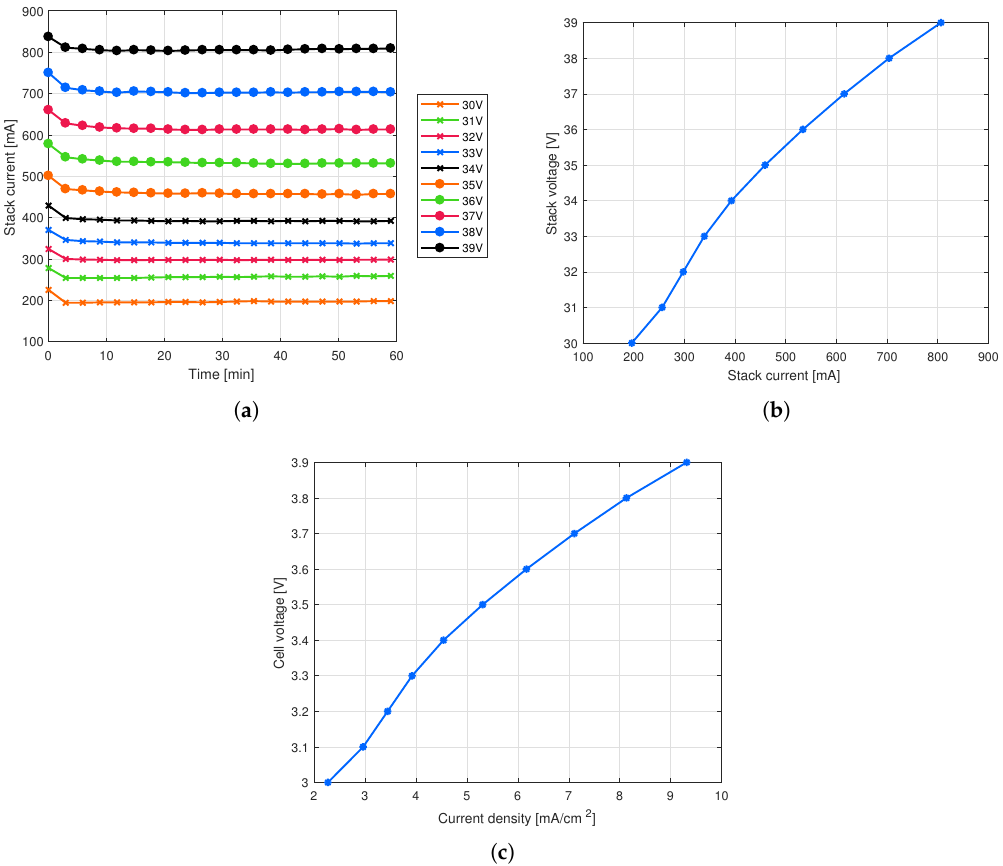
Figure 4. Measured currents and current densities of the electrolyzer stack with various supply voltages. ( a ) Measured currents as a function of time with various voltages; ( b ) stack voltage as a function of stack current; ( c ) cell voltage as a function of current density.